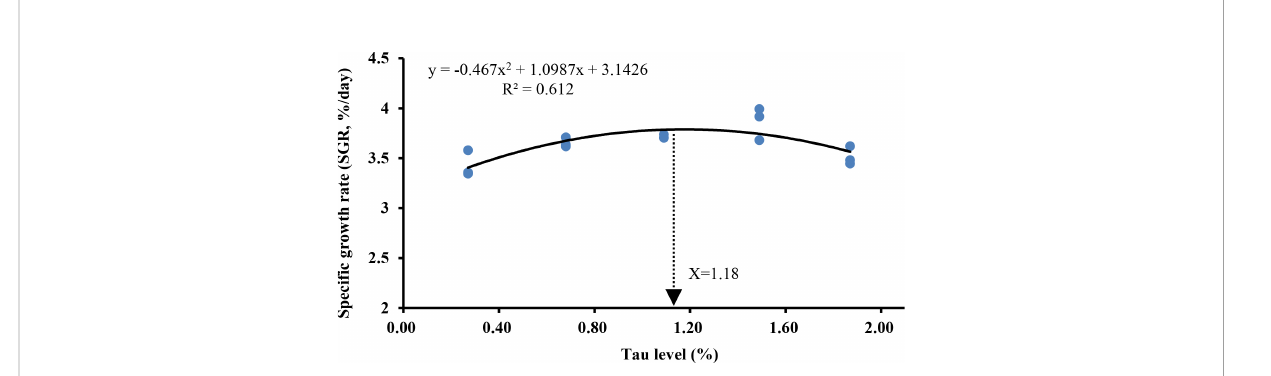
FIGURE 1 Estimation of the optimal dietary taurine level for T. ovatus by means of polynomial regression analysis using the SGR.